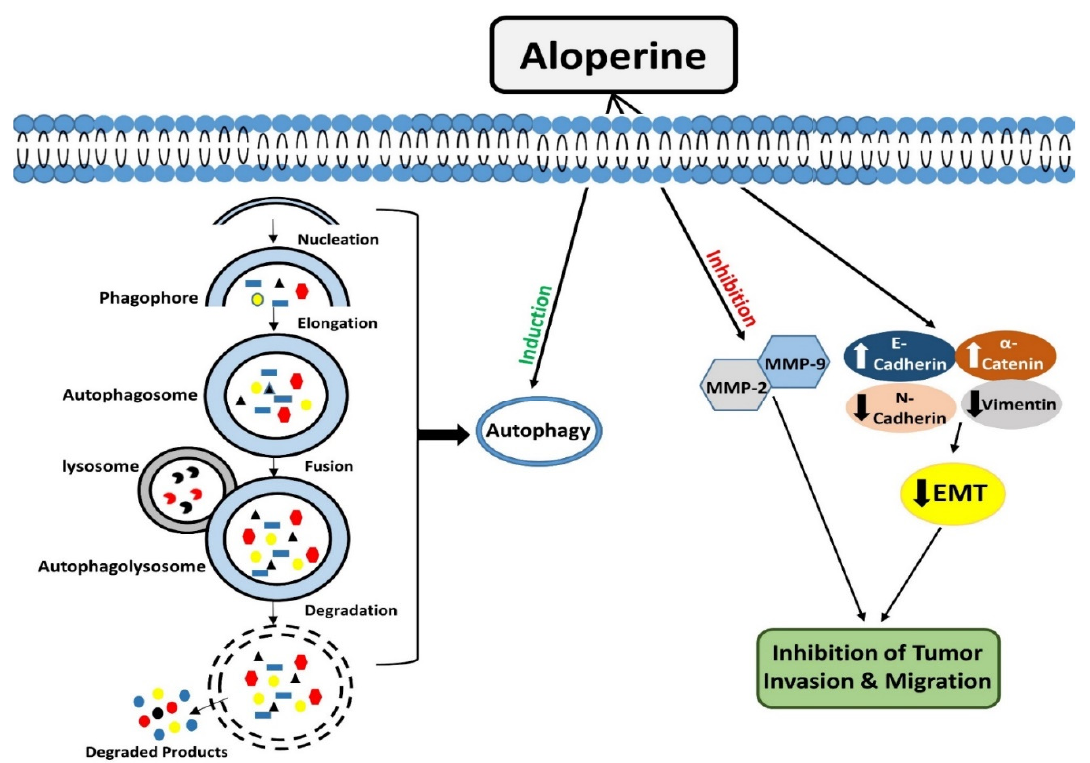
Figure 2. Modulatory effects of aloperine on autophagy and tumor cell invasion & migration.